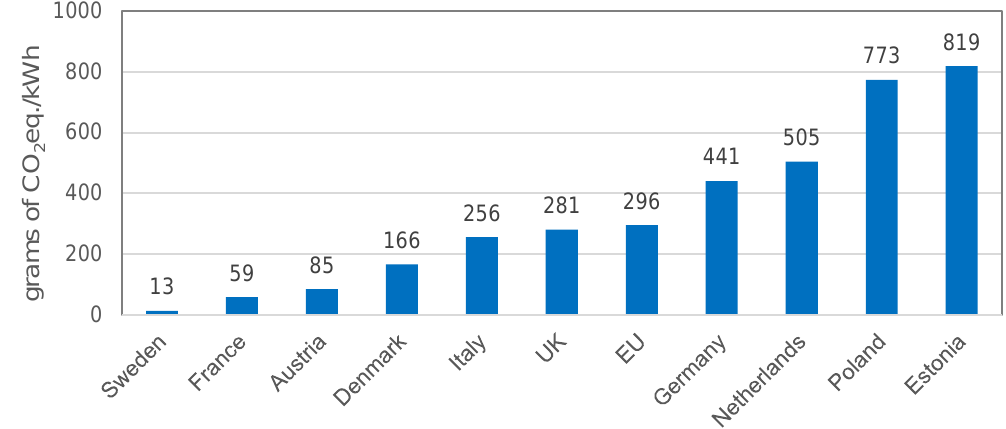
Figure 1. CO 2 emission from electricity production for selected European countries for 2016, in g CO 2 equivalent/kWh.